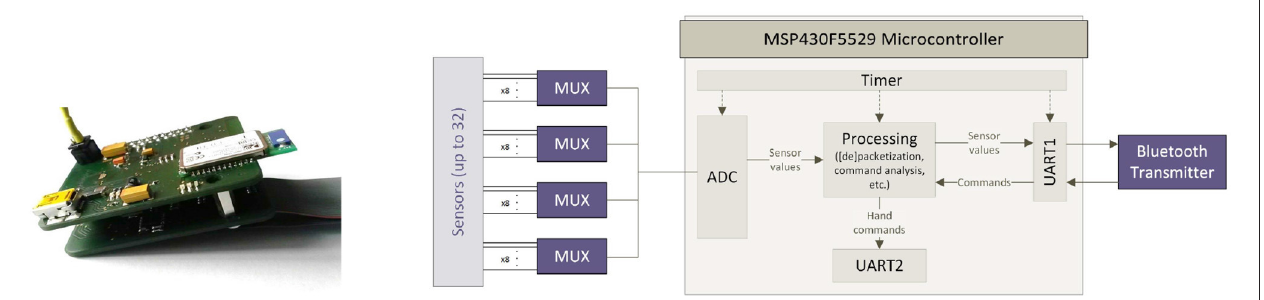
FIGURE 4 | The bluetooth analog-to-digital conversion board and its functional block